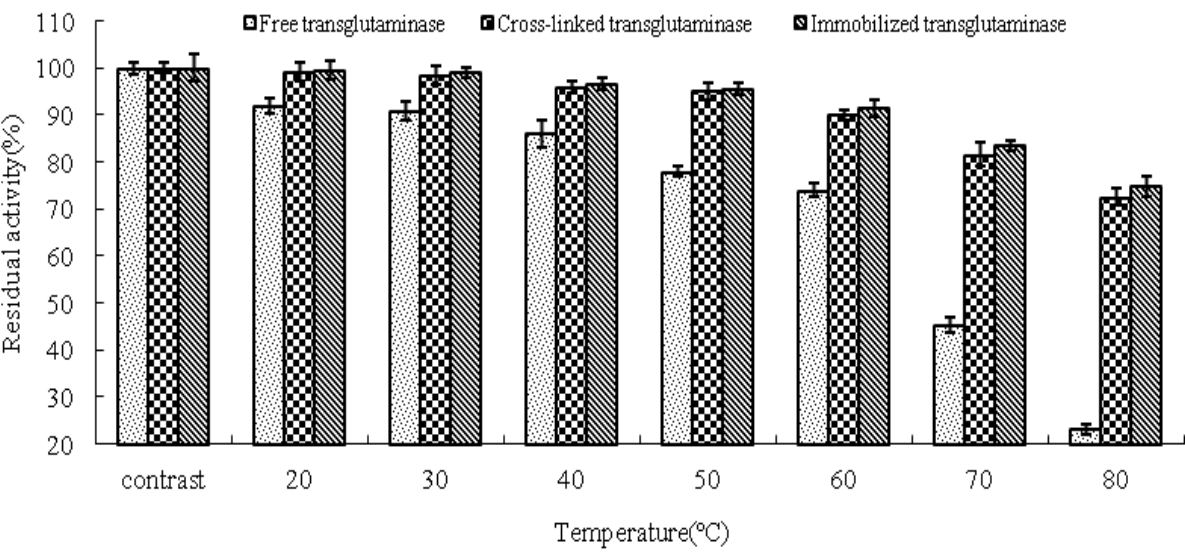
Figure 4. Thermal stabilities of the free, cross-linked and immobilized transglutaminase at different temperatures. Data are expressed as the % residual enzyme activity compared with the